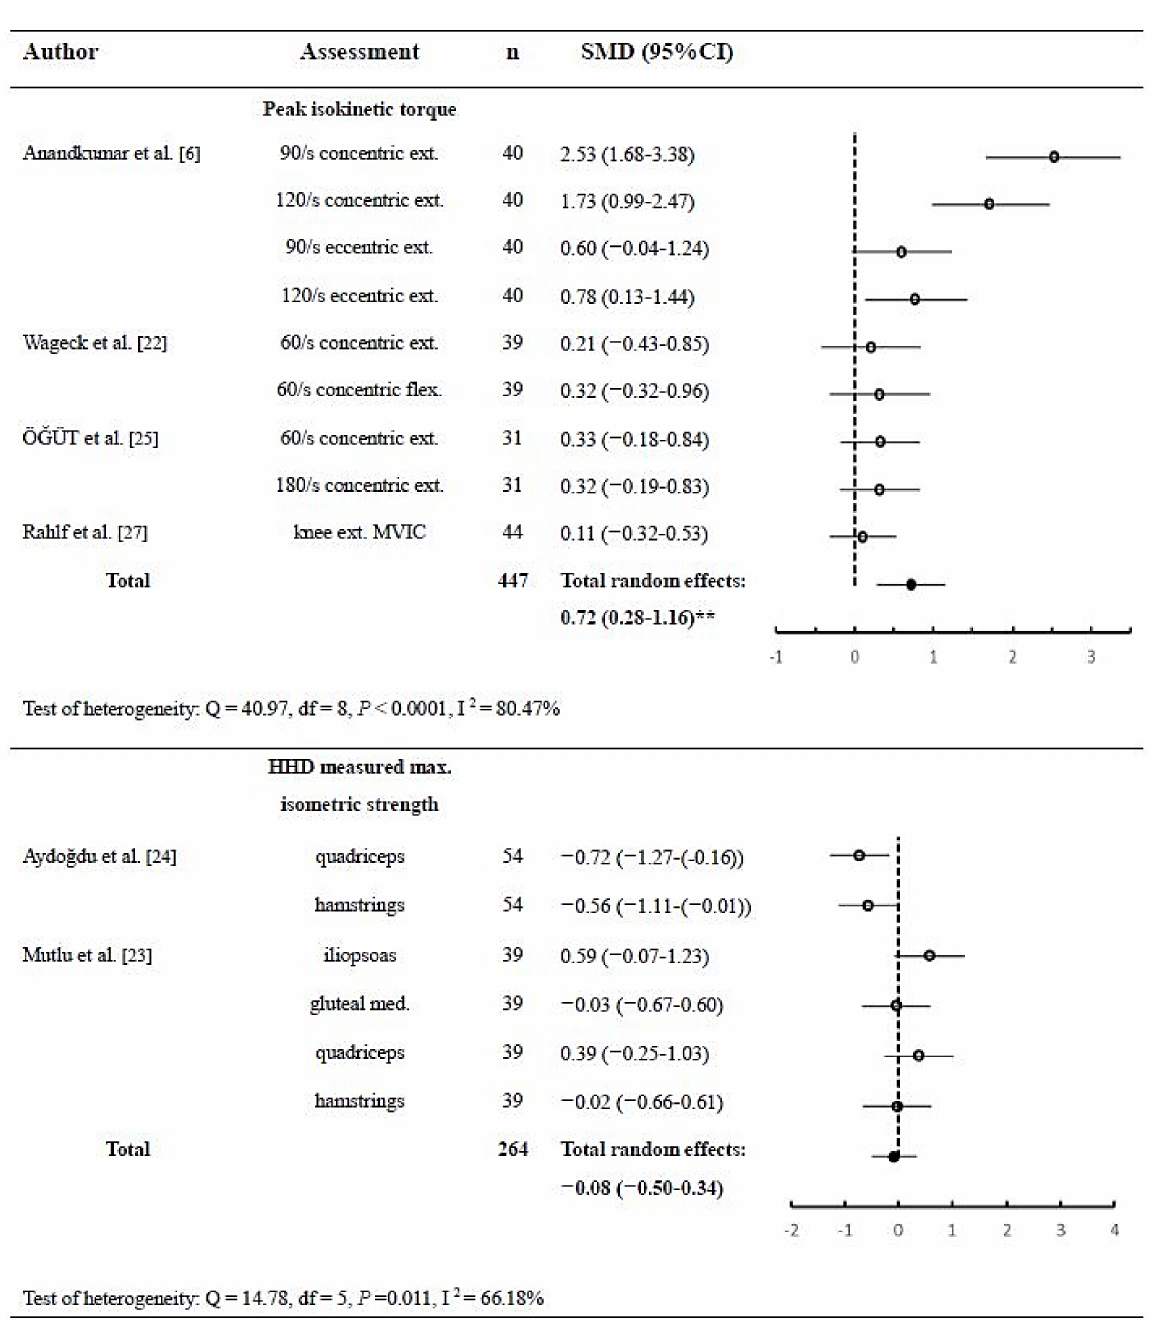
Figure 3. Pooled estimate of the effects of kinesio taping in peak isokinetic torque and maximal isometric strength measured by HHD ** p < 0.05 ( n = number of subjects; SMD = standard mean difference; flex. = flexion; ext. = extension; MVIC = maximal voluntary isometric contraction; df = degree of freedom; HHD = handheld